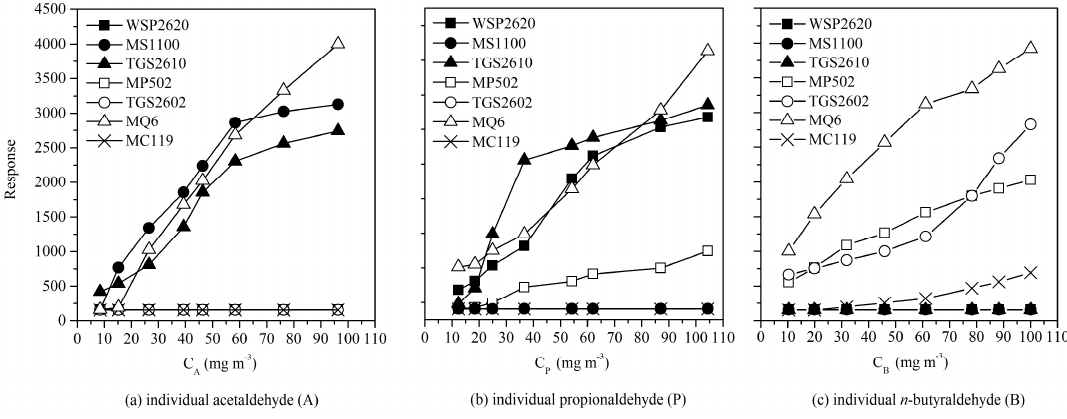
Figure 4. The concentration dependence of sensor response when single aldehydes were measured.